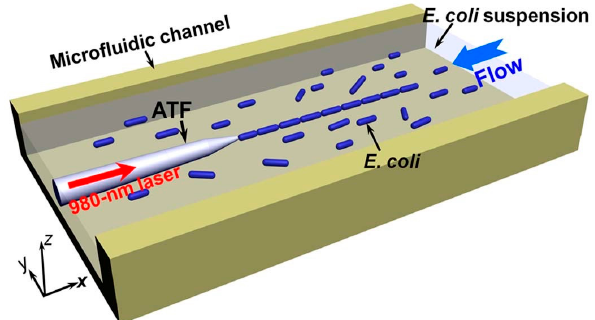
Figure 12. Schematic of cell–cell contact realization and retaining process. A laser at 980 nm was launched into an abrupt tapered fiber (ATF), which was placed in the microfluidic channel with a flowing suspension of E . coli cells. Multiple cells were trapped and connected in order at the tip of the ATF [64].